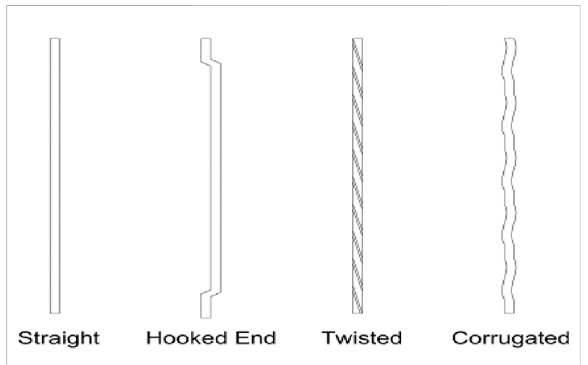
FIGURE 1 Steel fi ber shapes considered for incorporation in UHPC (Sidodikromo et al.,